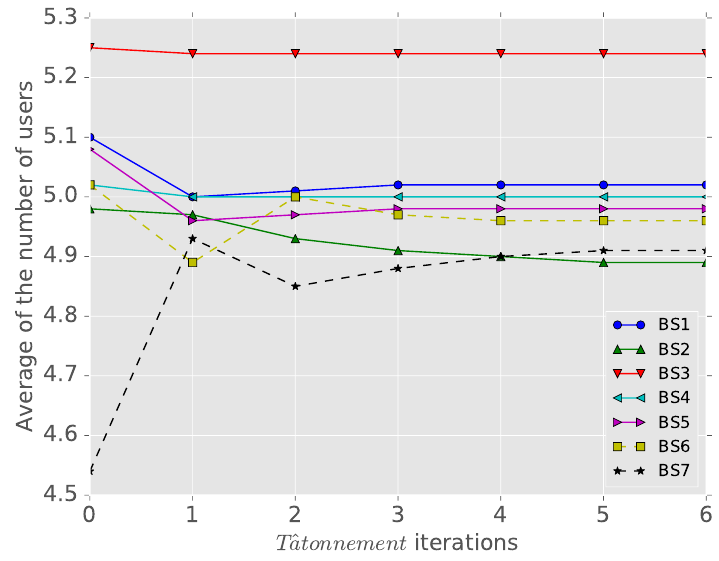
Figure 5. Resilience against mobile cluster